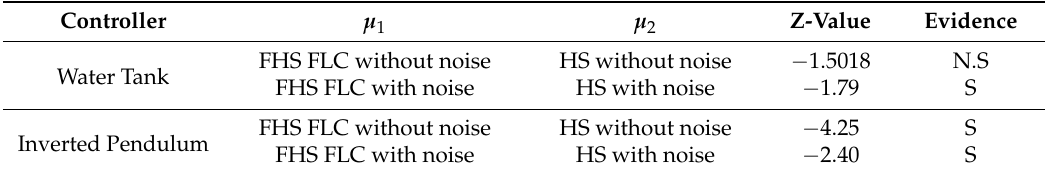
Table 17. Results for the statistical test with fuzzy harmony search